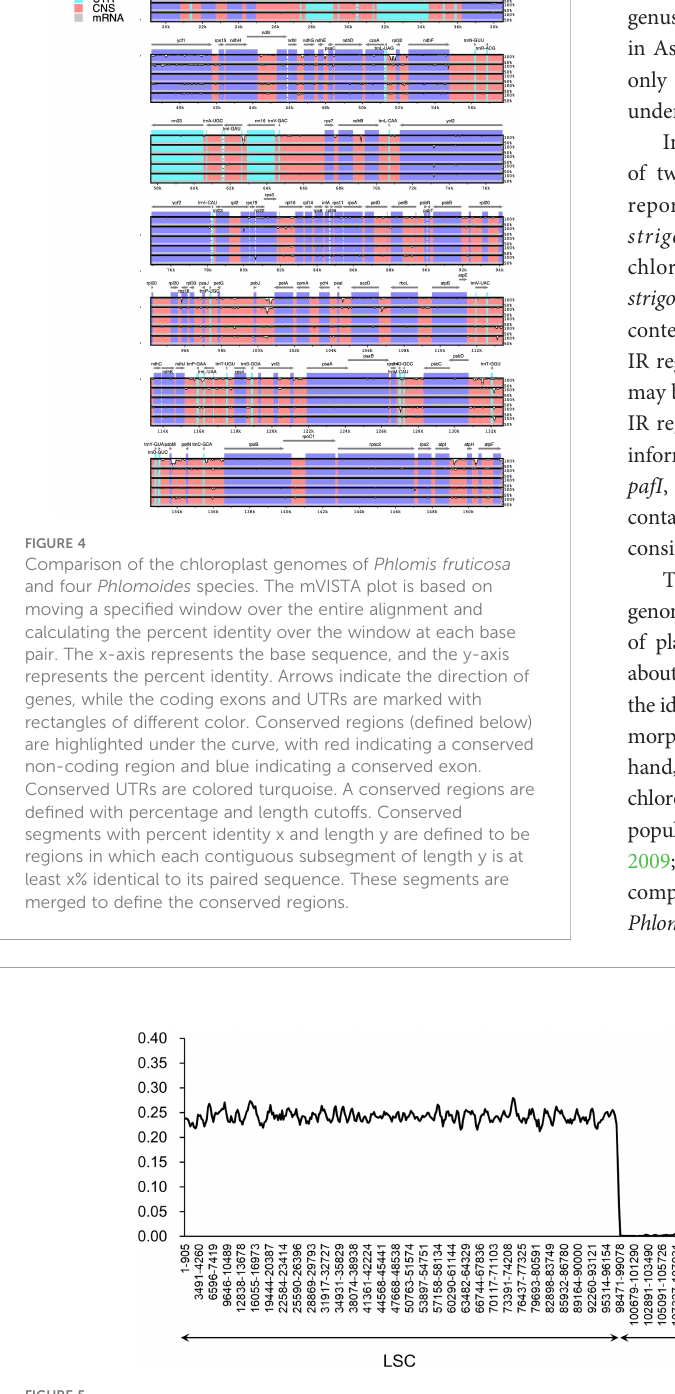
FIGURE 5 The nucleotide diversity of the plastid genome of Phlomis fruticosa and four Phlomoides species.